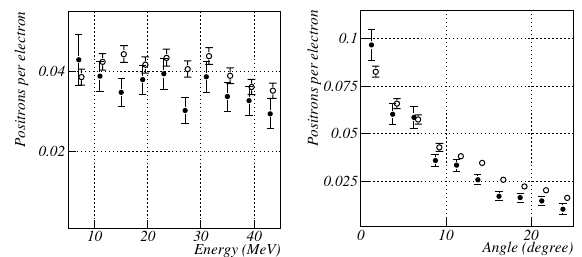
FIG. 1. Spectral (top) and angular (bottom) distributions of positrons from 10 GeVelectrons traversing a 8-mm-thick crys- tal tungsten target along the h 111 i axis. Open circles: simula- tion; filled circles: